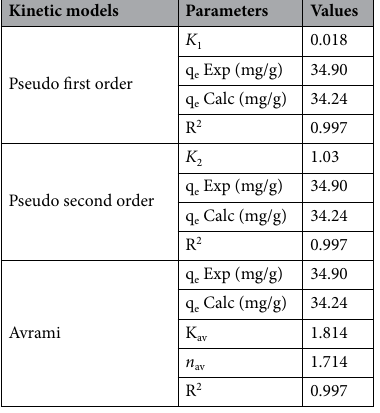
Table 4. Kinetic model parameters (MO + : 30 mg/L; Zn–Fe LDH: 0.01 mg/50 mL).